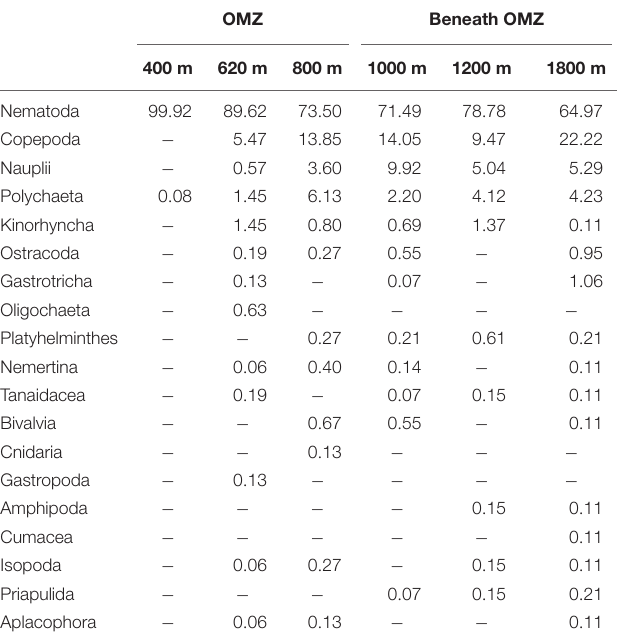
TABLE 2 | Relative abundance (%) of meiofaunal taxa at six sites sampled along the slope off Costa Rica.